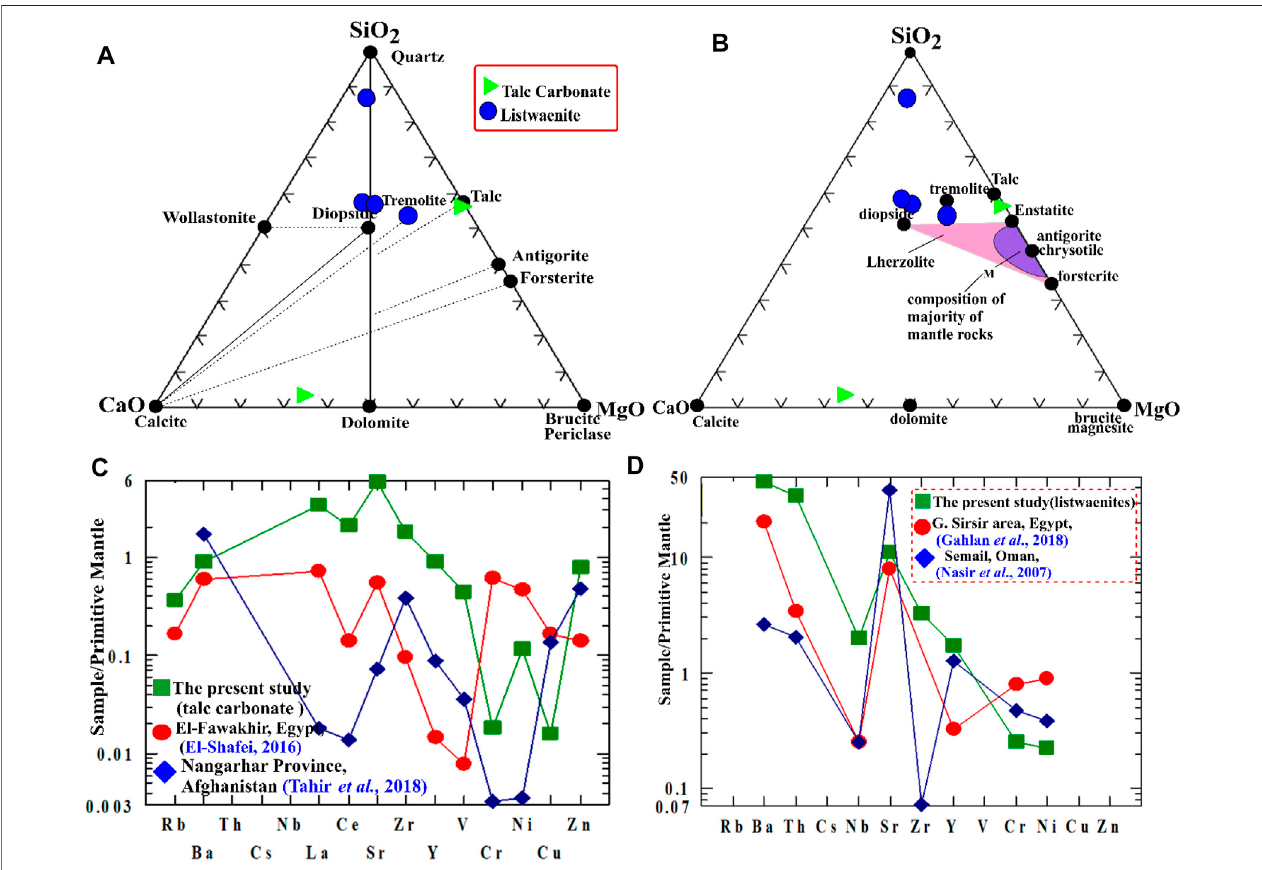
FIGURE13|(A) SiO 2 – CaO – MgOdiagramforlistwaenitesand talc-carbonaterocks (Bucher andGrapes,2011). (B) SiO 2 – CaO – MgOdiagramforlistwaenitesand talc-carbonaterocks (Bucher andGrapes, 2011). (C) Primitivemantle-normalizationresultsoftheaveragegeochemicalofpresentsamplesoftalc-carbonatecompared with El-Fawakhir (Egypt) and Nangarhar province (Afghanistan). (D) Primitive mantle-normalization values of the average geochemical results of present listwaenite samples compared with Sirsir (Egypt) and Semail (Oman) area.